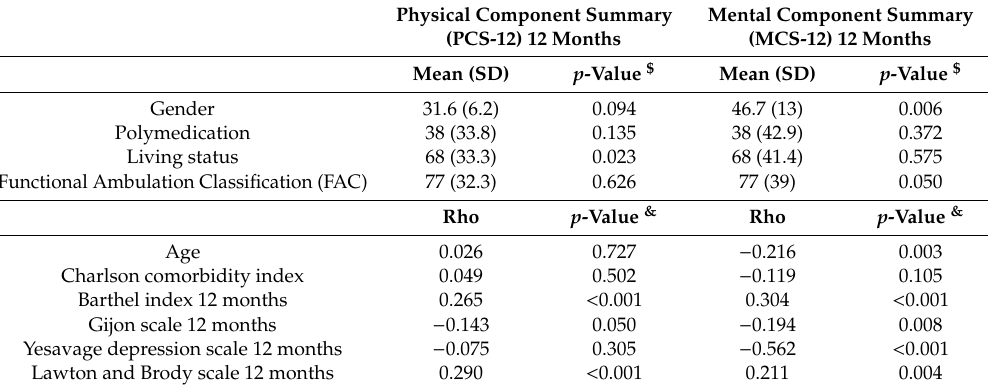
Table 3. Variables associated with the summary dimensions of the SF-12 questionnaire at 12 months after the surgical